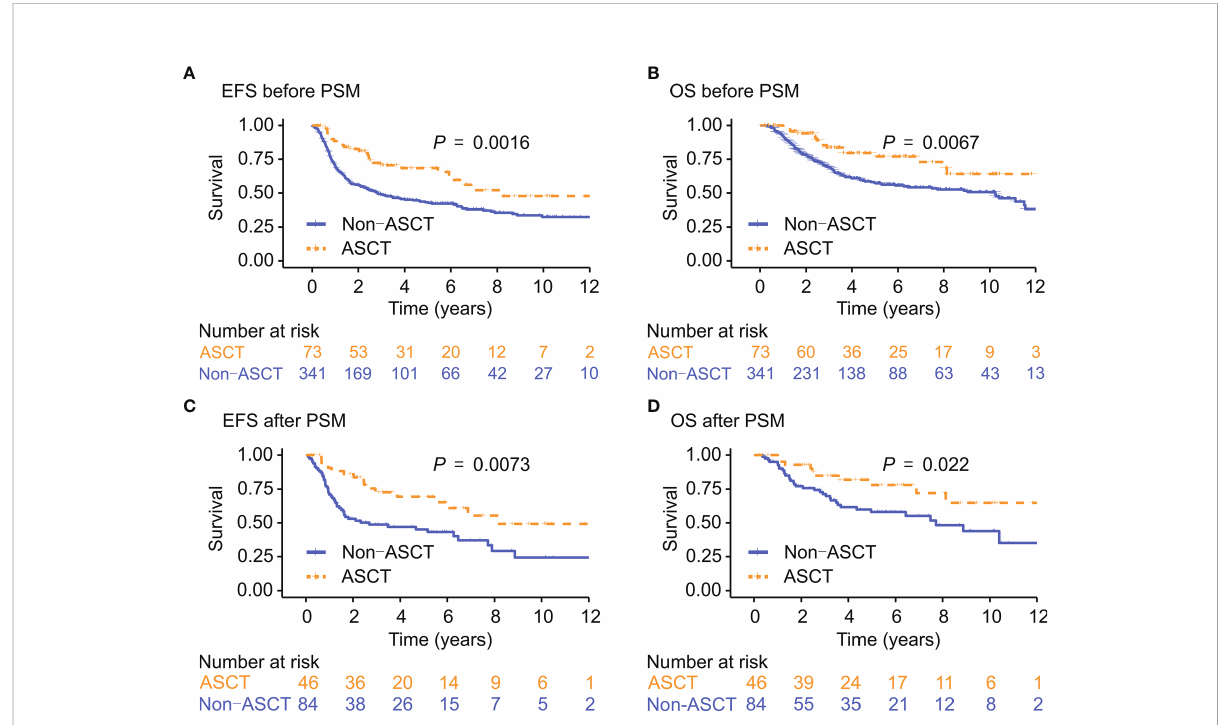
FIGURE 1 EFS and OS in the ASCT group and the non-ASCT group before and after PSM. EFS, event-free survival; OS, overall survival; ASCT, autologous stem cell transplantation; PSM, propensity score matching. Kaplan-Meir analysis of EFS (A, C) and OS (B, D) , before and after